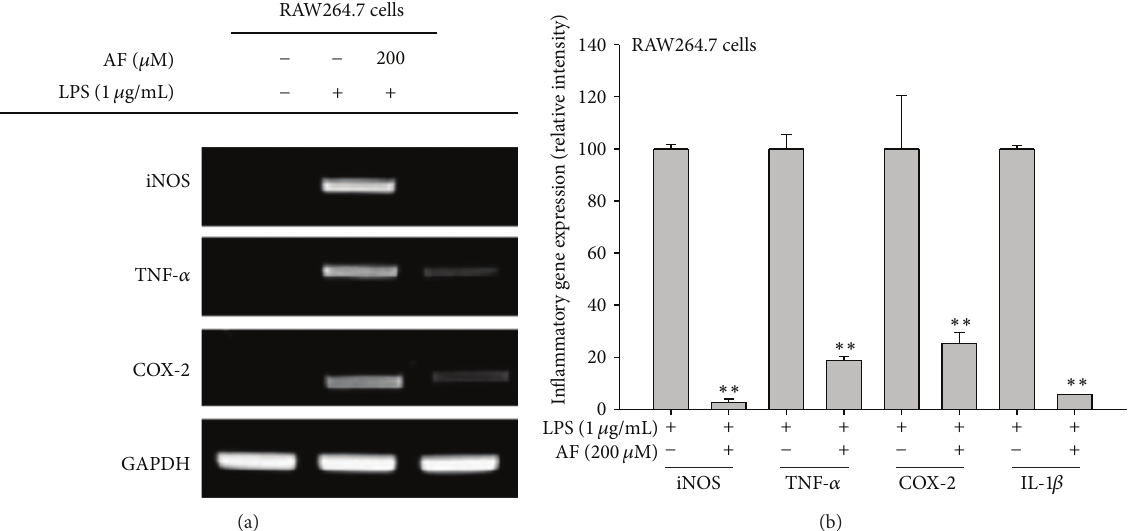
Figure 2: Effect of amentoflavone on mRNA expression of proinflammatory genes. (a and b) The mRNA levels of iNOS, COX-2, IL-1 𝛽 , and TNF- 𝛼 in RAW264.7 cells pretreated with or without AF (200 𝜇 M) for 30min and then exposed to LPS (1 𝜇 g/mL) for 6h were determined using semiquantitative (a) and real-time (b) PCR. RI: relative intensity. ∗∗ 𝑃 < 0.01 compared to the